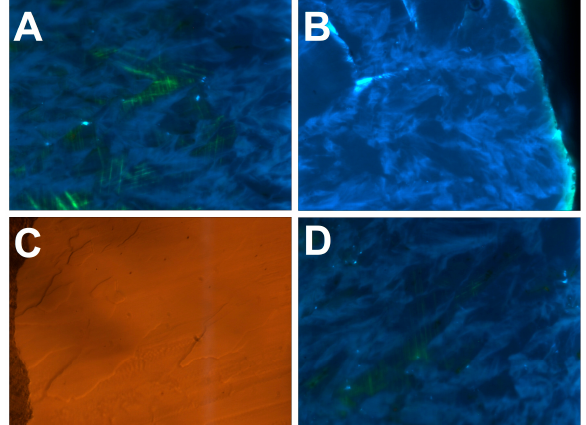
Figure 7. Details of cathodoluminescence (CL) and optical reflection images ( B )—the “small” sample, other panels—the “large” one). Width of every image—300 µ m. ( A )—misoriented single crystals separated by the “feathers”. The misorientation is visualized by the relative orientation of the glide planes. ( B )—the “feathers” reaching the growth surface often give rise to hillocks. ( C , D )—optical reflection and CL image of the same region, one can see that the “feathers” often show negative relief after the polishing.